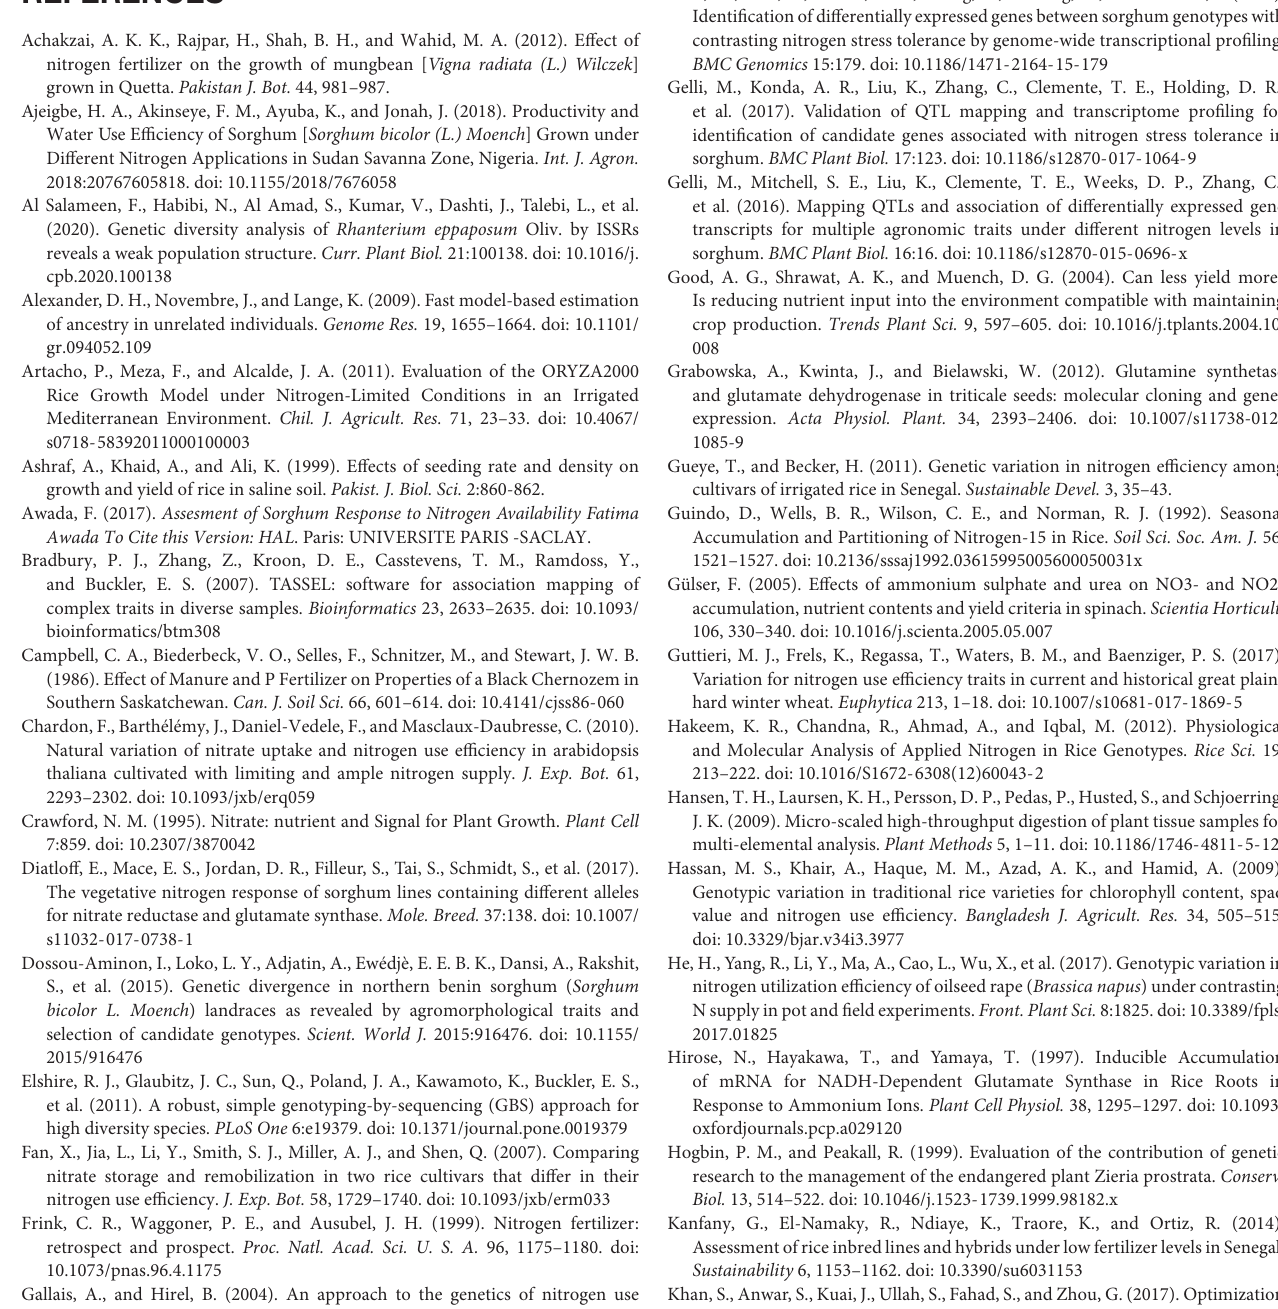
Supplementary Table 3 | List of gene specific primers used for studying expression profiles of N uptake assimilatory and remobilization related genes in shoot and root tissues of contrasting sorghum